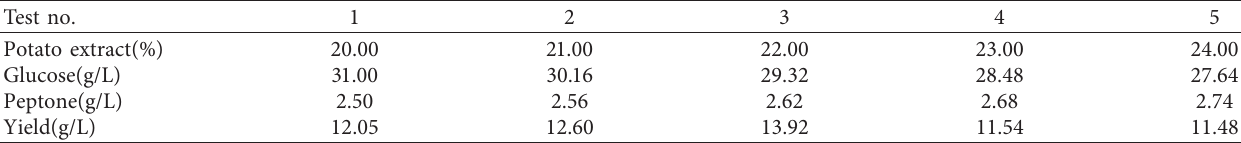
Table 6: Design and results of the steepest ascent experiment. Potato extract(%)